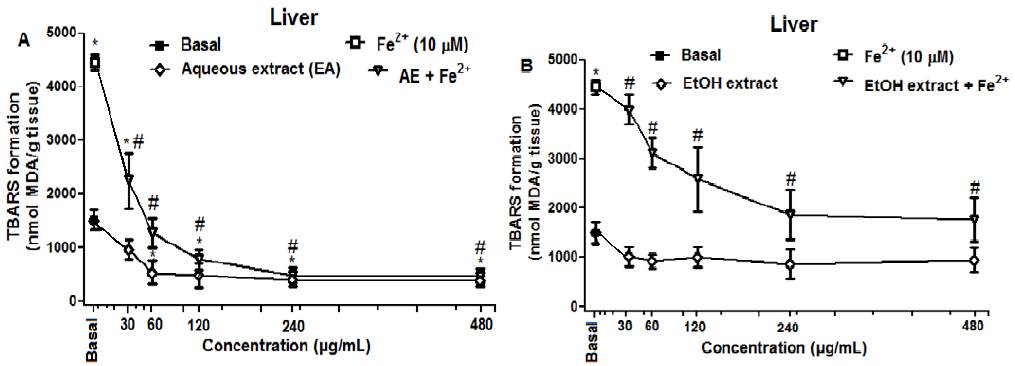
Figure 4. Effect of aqueous ( A ) and ethanolic ( B ) extracts of the leaves of R. echinus on lipid peroxidation induced by iron in rat liver homogenates. The homogenate was incubated for 1 h with Fe 2+ (10 μ M) in the presence or absence of different concentrations of the extracts. Values represent the mean of n = 3 independent experiments performed in duplicate ± SEM. *: p < 0.05 vs. basal and #: p < 0.05 vs. Fe 2+ .